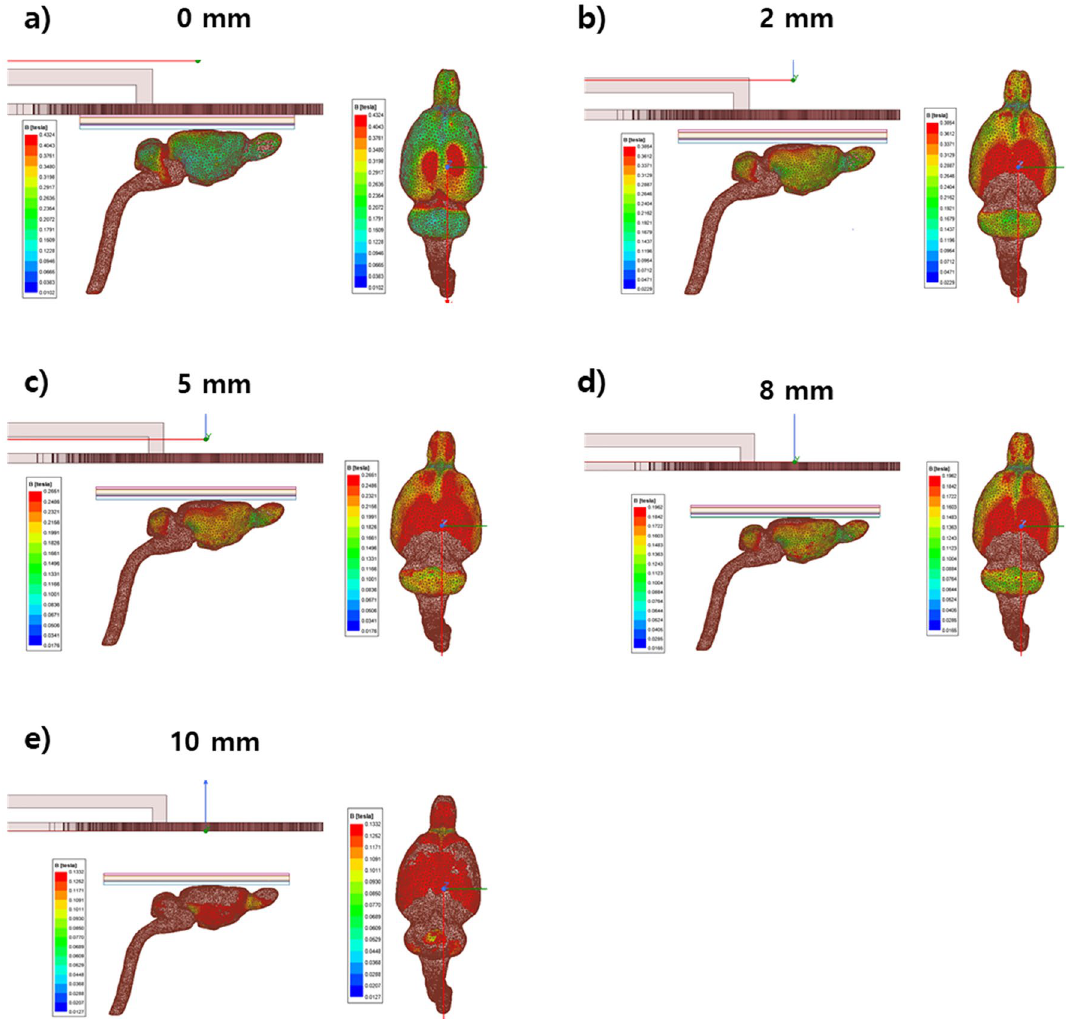
Figure 10. Magnetic field intensity simulation using the mice brain model. The distance between the coil and brain model varied: ( a ) 0 mm apart; ( b ) 2 mm apart; ( c ) 5 mm apart; ( d ) 8 mm apart; and ( e ) 10 mm